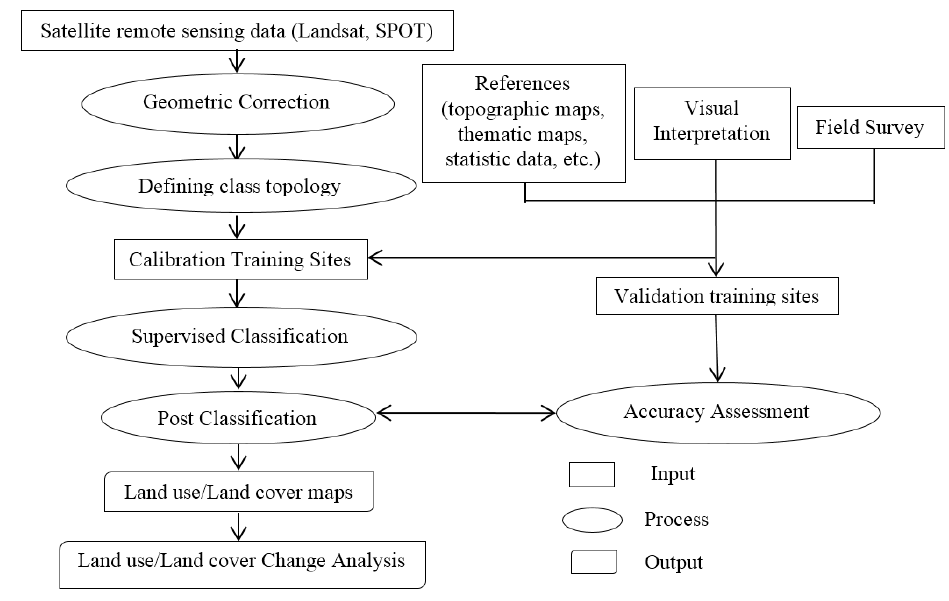
Figure 2. Flowchart of the processing of satellite data in this